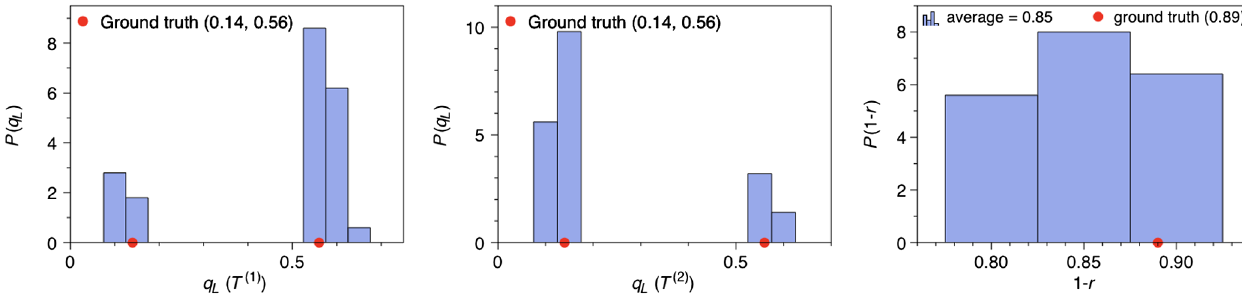
FIG. 20. Probability density of each parameter obtained from the 100 Monte Carlo samples of Fig.